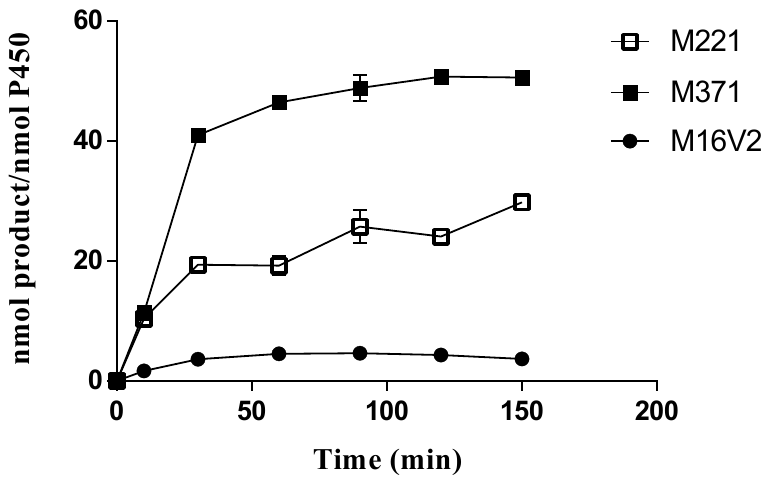
Figure 7. TTNs of phlorizin hydroxylation by CYP102A1 mutants. The reactions contained 0.2 mM of phlorizin substrate and 0.40 μM of CYP102A1 (M221, M371, and M16V2) in potassium phosphate buffer (100 mM, pH 7.4). To initiate the reaction, NADPH-generating systems were added to the reaction mixtures and incubated for 10, 30, 60, 90, 120, and 150 min at 37 °C.